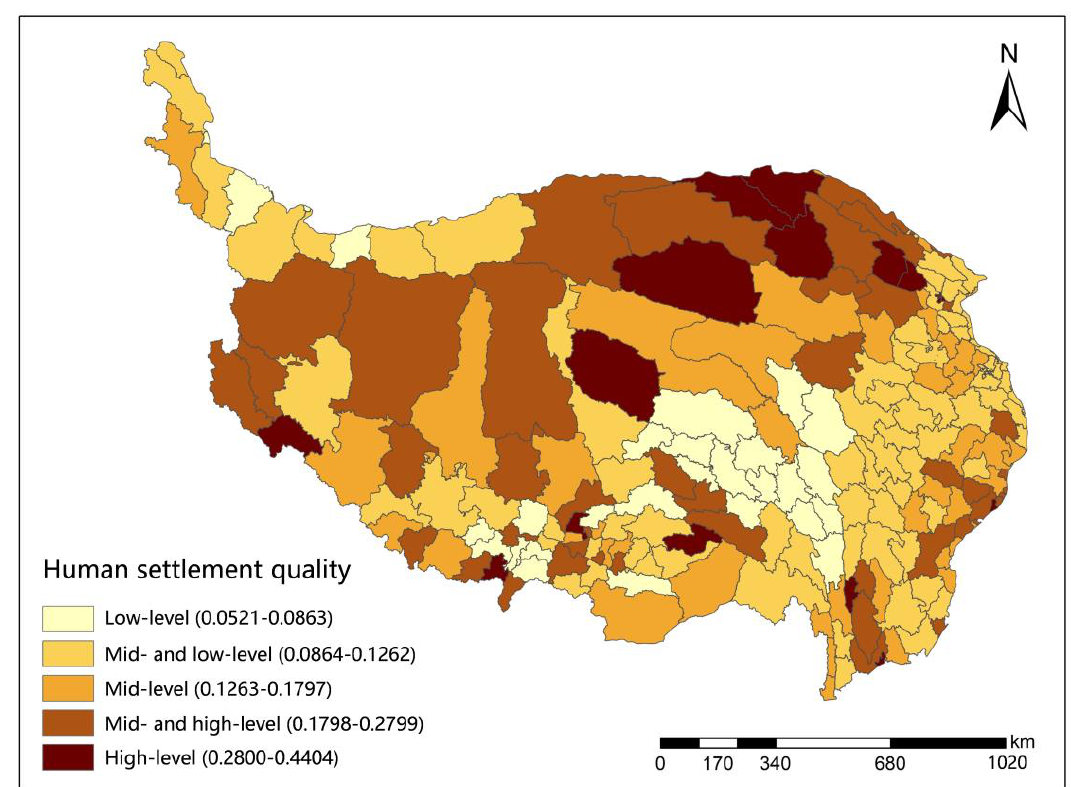
Figure 4. Spatial distribution of human settlement quality in the Qinghai–Tibet Plateau.